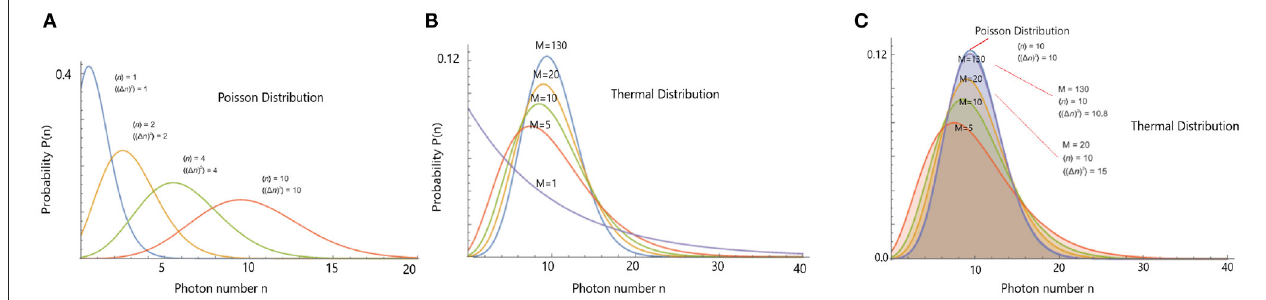
n . (B) Demonstration of thermal field photocount distribution for different h i n ) approaches Poisson distribution for a large h i